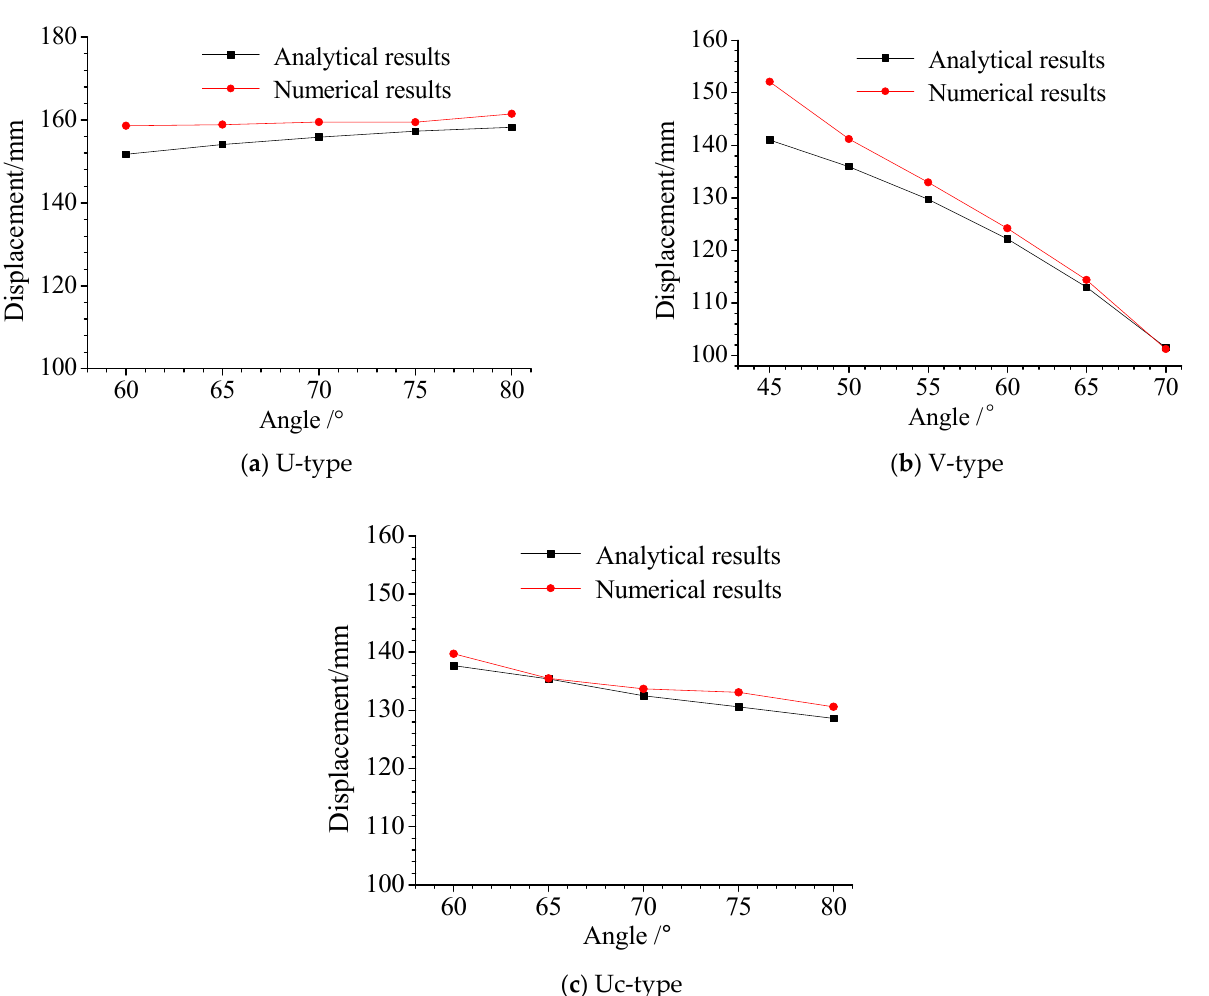
Figure 13. Displacement curves of the sandwich structure with different angles.